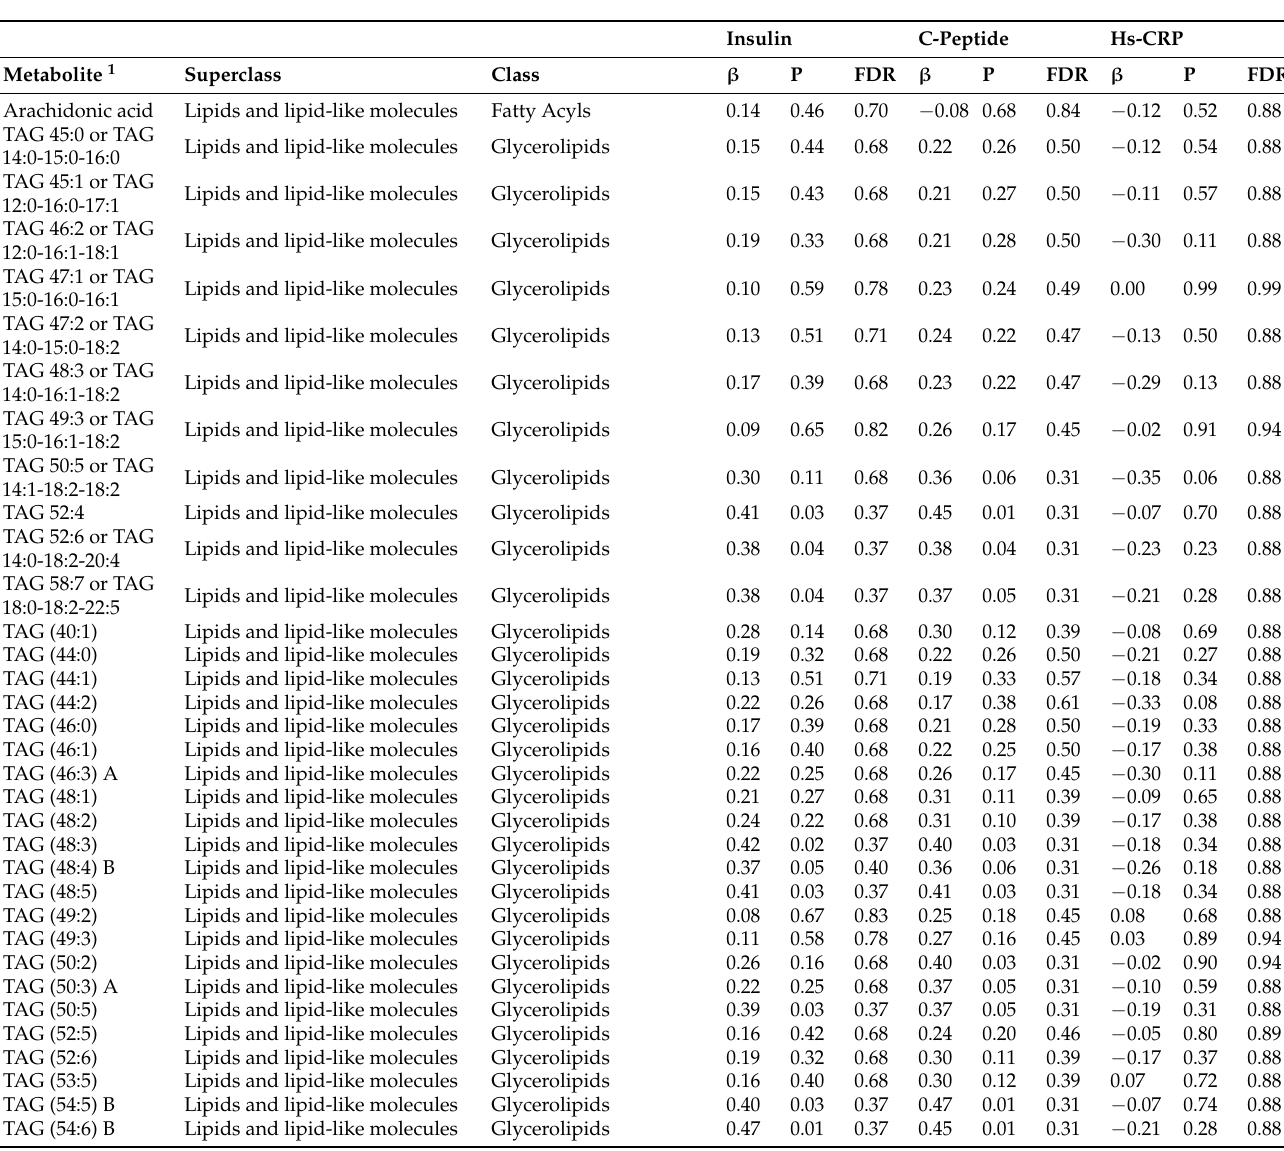
Table 3. Pearson correlations between 88 metabolites and three cardiometabolic biomarkers at 32 weeks of